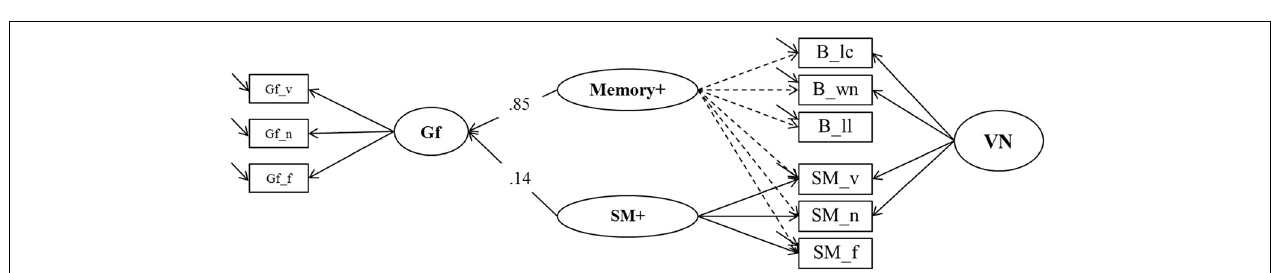
Factor; _v, verbal indicator; _n, numerical indicator; _f, figural indicator; _lc, letter-color; _wn, word-number; _ll, location-letter.